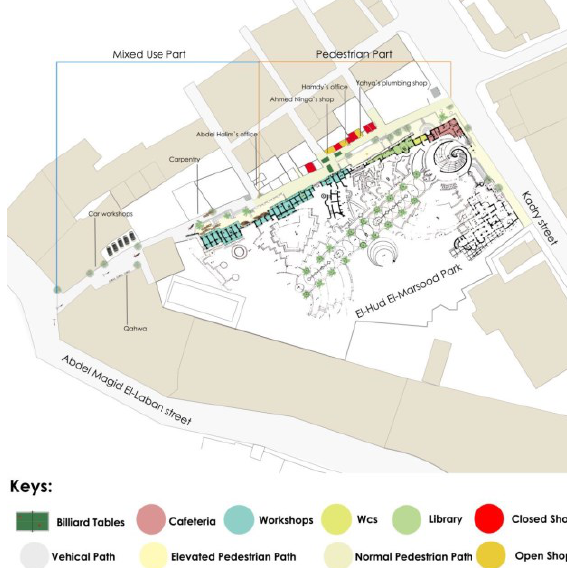
Figure 6 : Activity and Users’ Mapping of the Park and adjacent street, BTU-Cottbus Double Msc Degree Students, 2017.